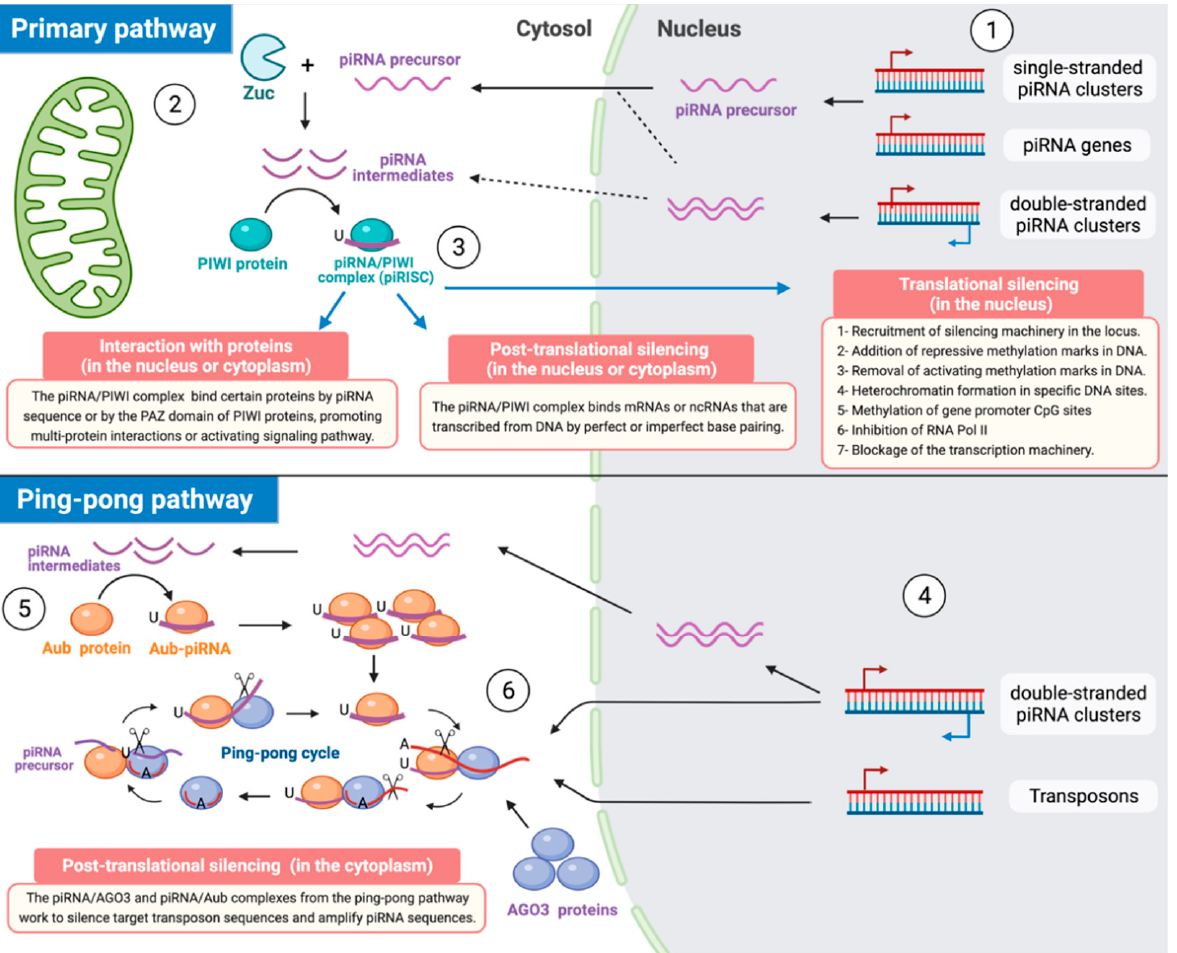
Figure 1. The biogenesis of piRNAs consists of two main processes the primary and the ping-pong pathways. In the primary pathway, (1) piRNAs’ precursors (pre-piRNAs) are transcribed from genomic regions such as piRNA clusters (single- and double-stranded) and piRNA genes by RNA Pol II. Then, (2) pre-piRNAs are processed by Zuc and other proteins to form piRNA intermediates to be then loaded onto PIWI protein. Then, (3) these primary piRNAs (piRISCs) are edited once again to finish the maturation process before starting their gene-silencing activity or protein interacting in both the nucleus and cytoplasm. In the ping-pong pathway, (4) piRNAs proceed from dual-stranded sequences or transposons. Then, (5) the sequences are processed in different manners, binding Aub protein, for example. Finally, (6) piRNA/Aub and piRNA/AGO3 complexes work together in the cytoplasm to silence the target transposon sequences and amplify piRNA sequences at the same time. 4. The Functions of the piRNA/PIWI Complex PiRNAs can bind PIWI proteins to form piRISCs, which can influence transposon silencing, genome rearrangement, epigenetic regulation of gene expression, and protein regulation. Therefore, these molecules can be involved in physiological processes such as germ stem-cell maintenance, gametogenesis, etc., and in pathological processes such as